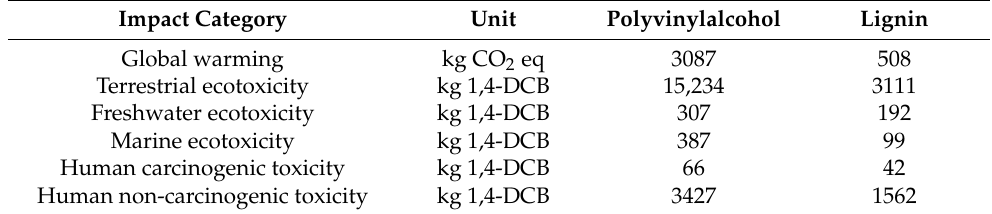
Table 4. Characterization of mulch film PVA with lignin (40PVA/60LN) using ReCipe Midpoint (H).